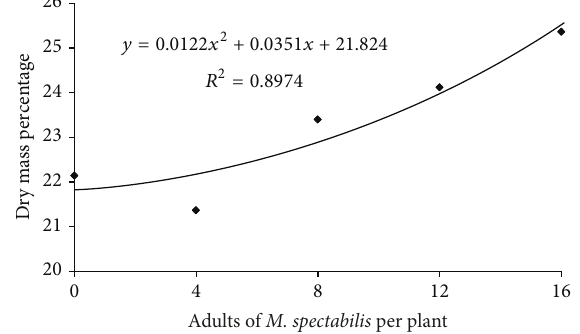
Figure 4: Relationship between infestation levels of M. spectabilis adults and dry mass percentage of the B. ruziziensis